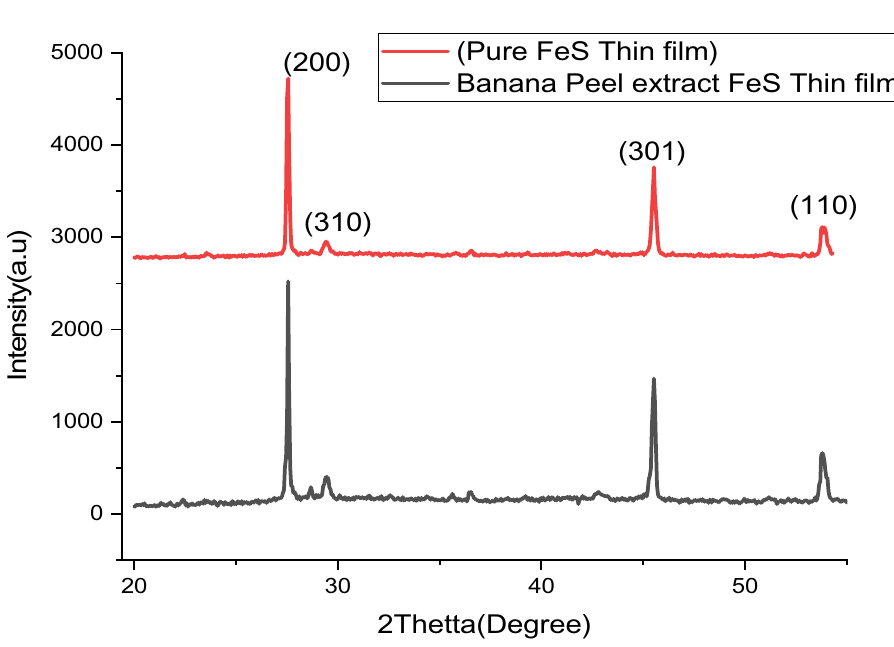
Figure 3. XRD configurations for iron sulfide thin films synthesized as nano-crystalline FeS from banana peel extraction and pure FeS thin